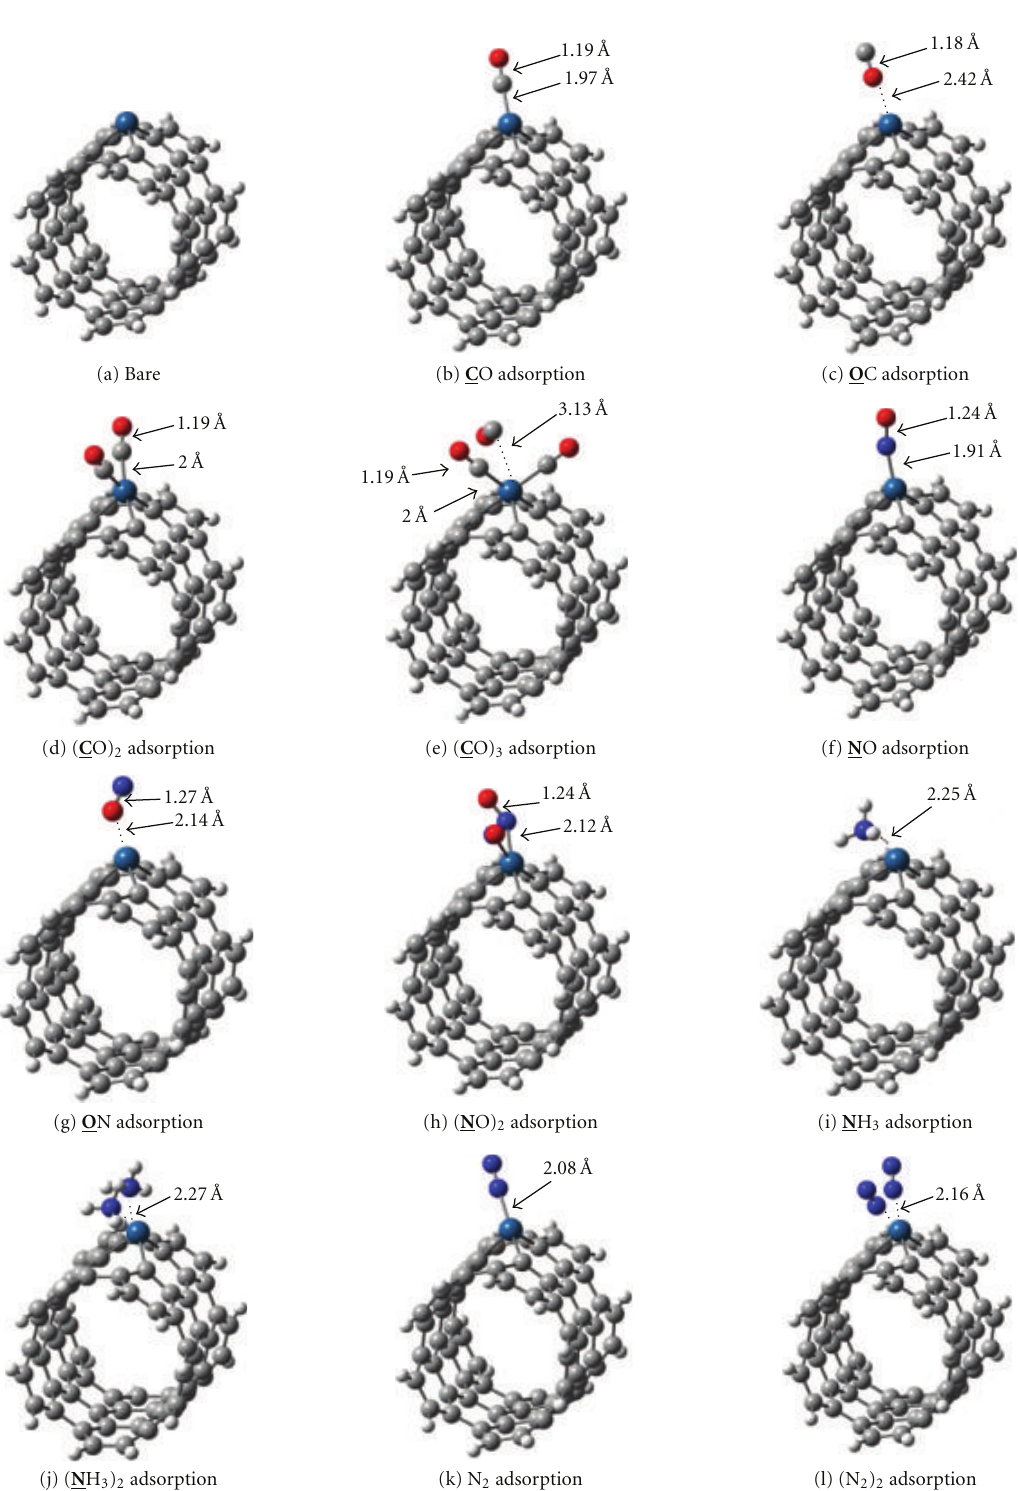
Figure 20: Optimized geometries for end-on adsorbed HSWCNTs [114]. Legend: dark grey = carbon, light grey = oxygen, navy blue = nitrogen, red = oxygen, blue =